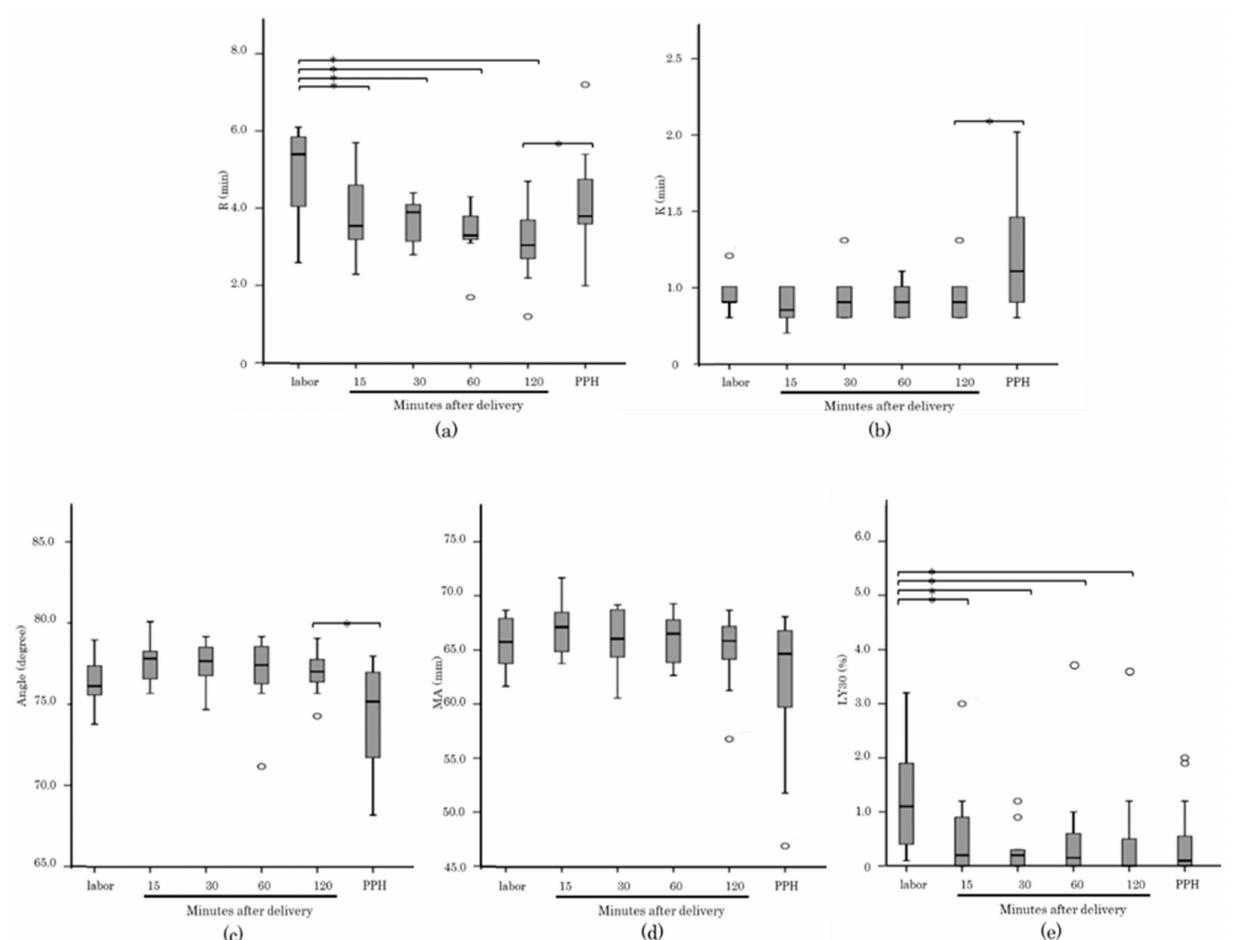
Figure 4. Box-and-whiskers plots showing the results of thromboelastographic parameters; R ( a ), K ( b ), Angle ( c ), MA ( d ), LY30 ( e ) in CK assays between 1st stage of labor, postpartum and postpar- tum hemorrhage (PPH). The band inside the box shows the median. The Mann-Whitney test was performed to calculate the p values (*: p <